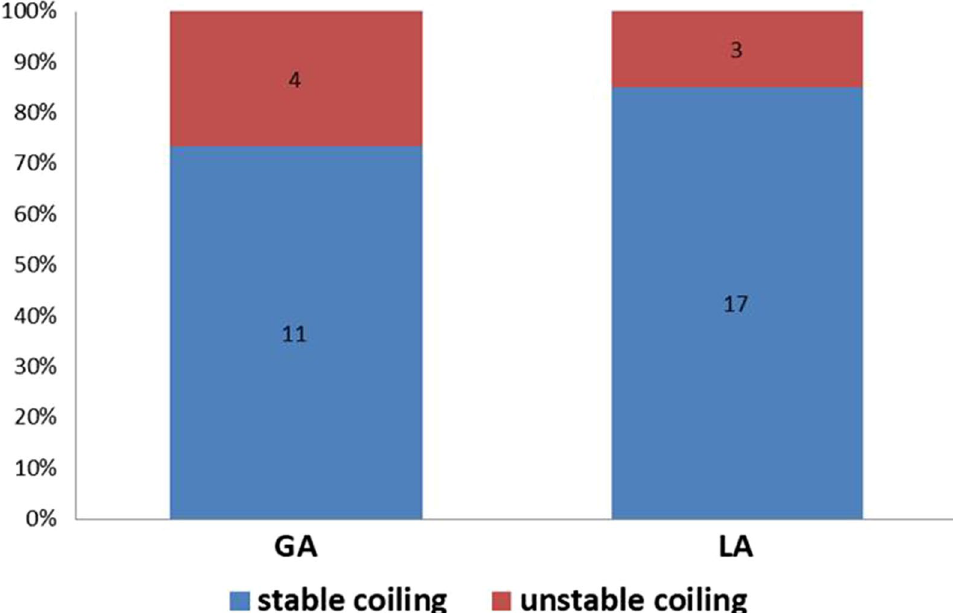
Fig. 3 Aneurysm obliteration in patients who were operated under LA and in patients who were operated under GA